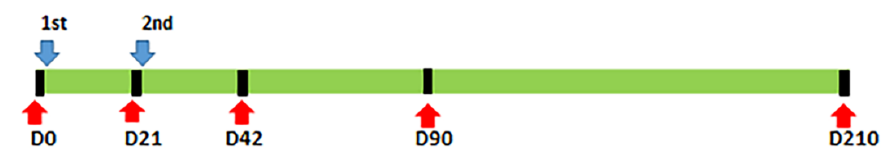
Figure 10. Schematic presentation of vaccination and serum collection.